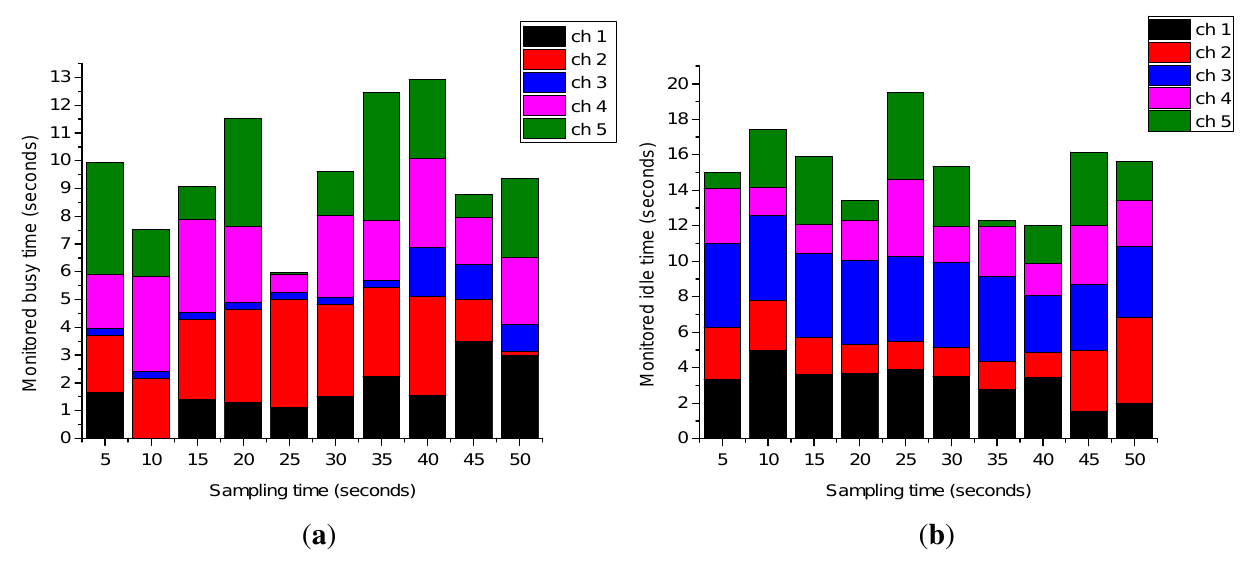
Figure 10. Monitored idle and busy time. ( a ) Detected total busy time; ( b ) detected total idle time.